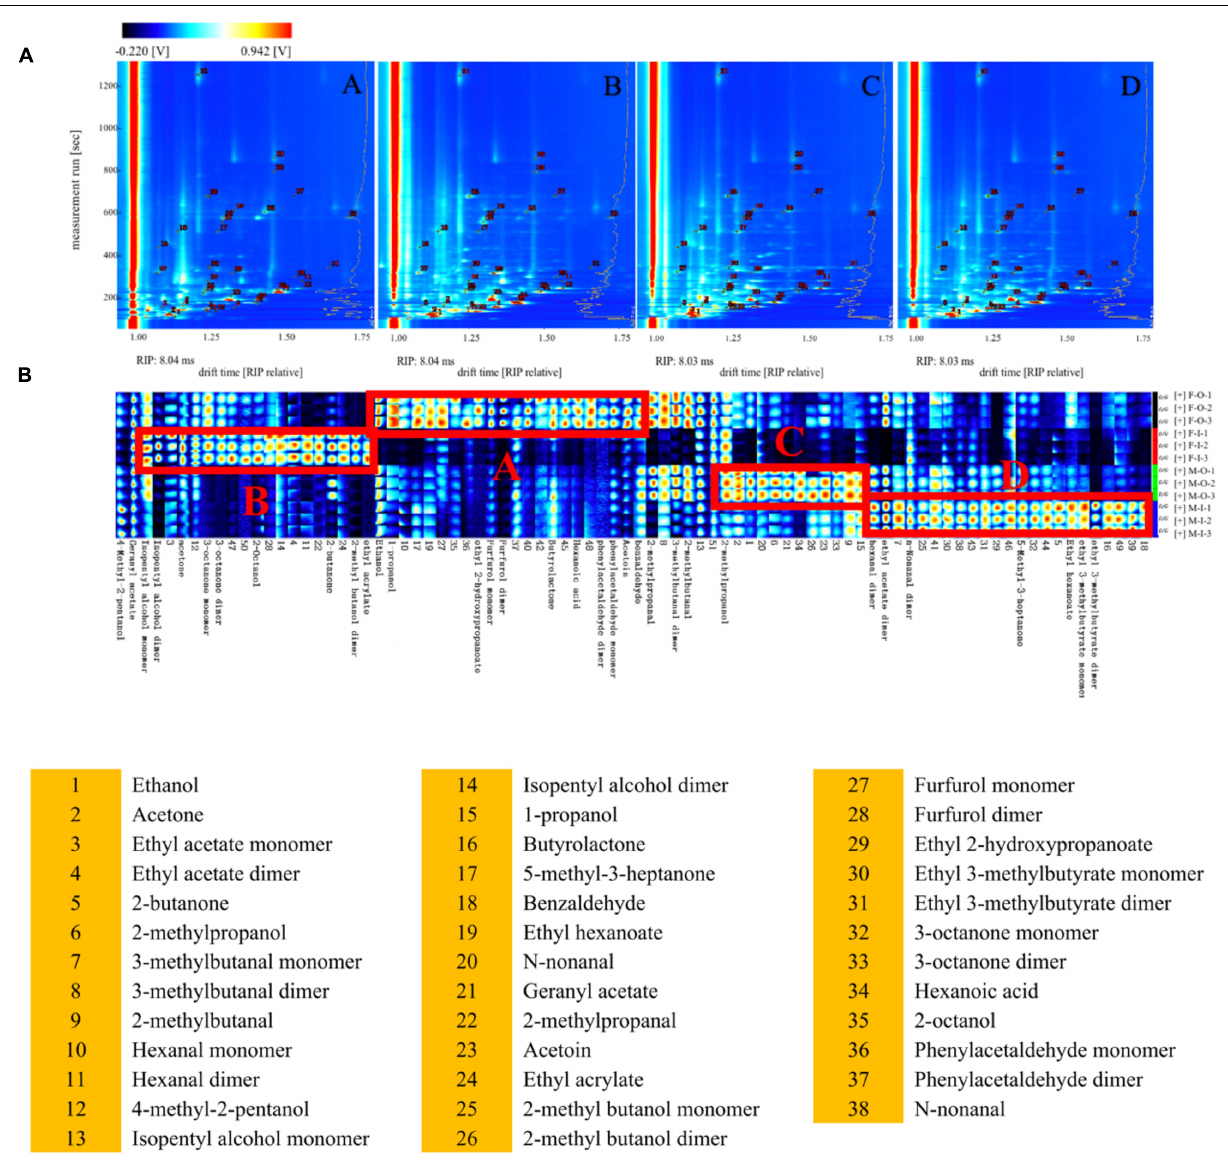
FIGURE 3 | Comparison (A) and fingerprints (B) of volatile flavors via HS-GC-IMS. A: Inner of fresh Daqu ; B: Outer of fresh Daqu . C: Inner of mature Daqu ; D: Outer of mature Daqu